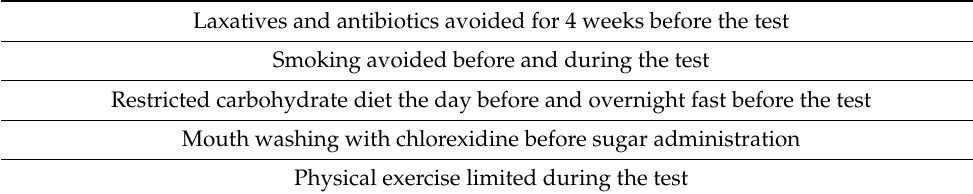
Table 1. Suggested protocol before performing breath testing. Laxatives and antibiotics avoided for 4 weeks before the test Smoking avoided before and during the